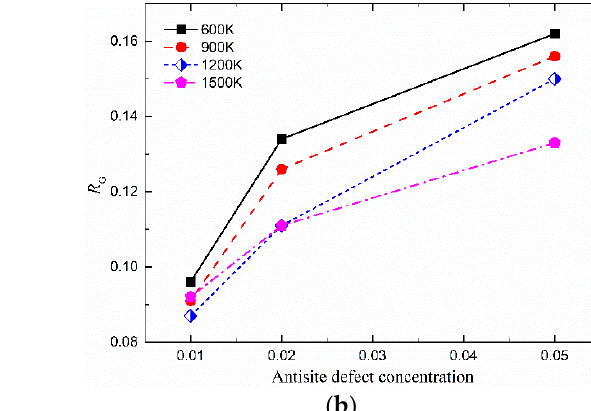
Figure 8. R B as a function of the concentration of Frenkel defects ( a ) and antisites ( b ) at different temperatures.